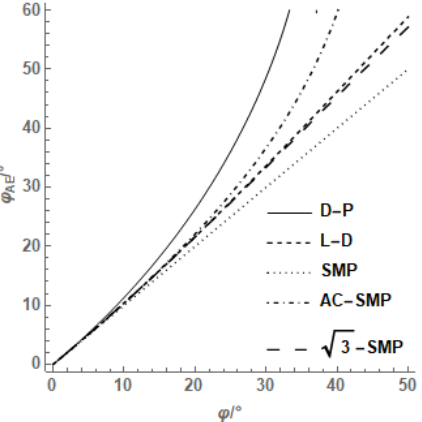
ϕ and AE ϕ . Figure 5. The relationship between ϕ and ϕ AE .